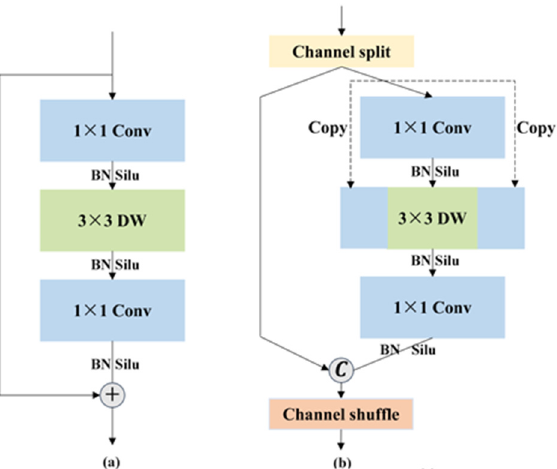
Figure 3. Structure of ( a ) bottleneck block and ( b ) asymmetric ShuffleBlock.